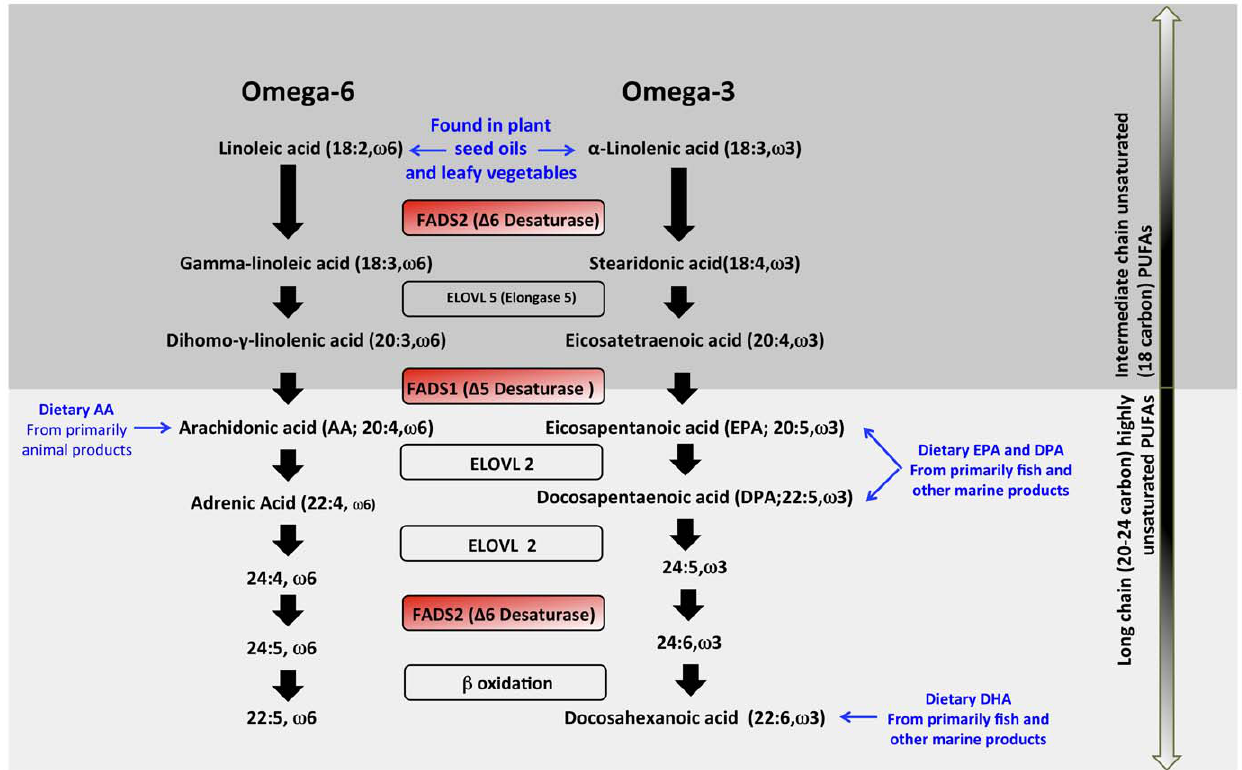
Figure 1. Overview of PUFA metabolism illustrating the critical involvement of FADS1 and FADS2 genes in desaturation steps necessary for the metabolism of intermediate chain unsaturated PUFAs (top dark gray panel) to long chain highly unsaturated PUFAs (bottom light gray panel). Omega 3 (right) and Omega 6 (left) pathways are illustrated along with known genes (in center rectangles) and dietary sources of the